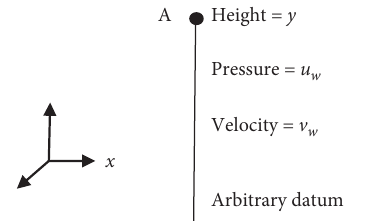
Figure 1: The energy of point A in the y direction of an arbitrary